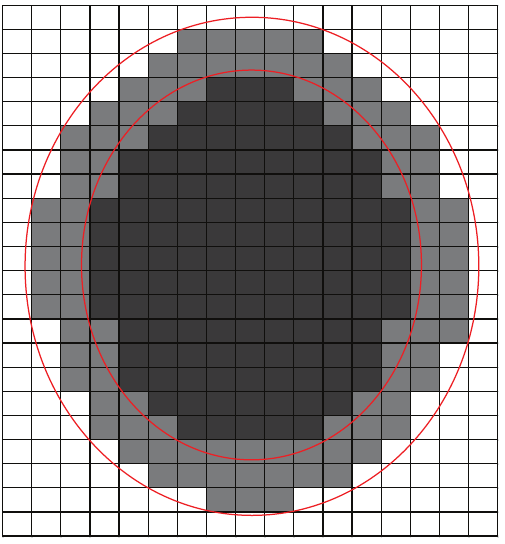
Figure 2: Lower approximation set of an interval